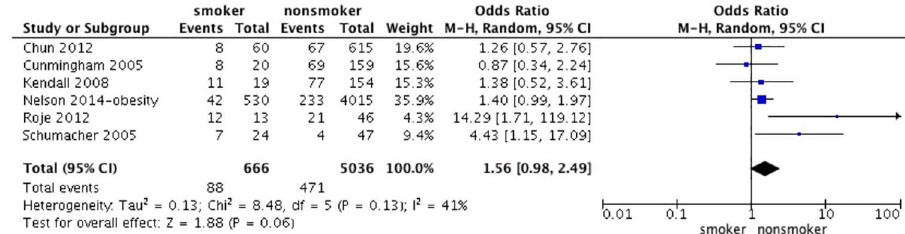
Fig 6. Correlations between smoking and